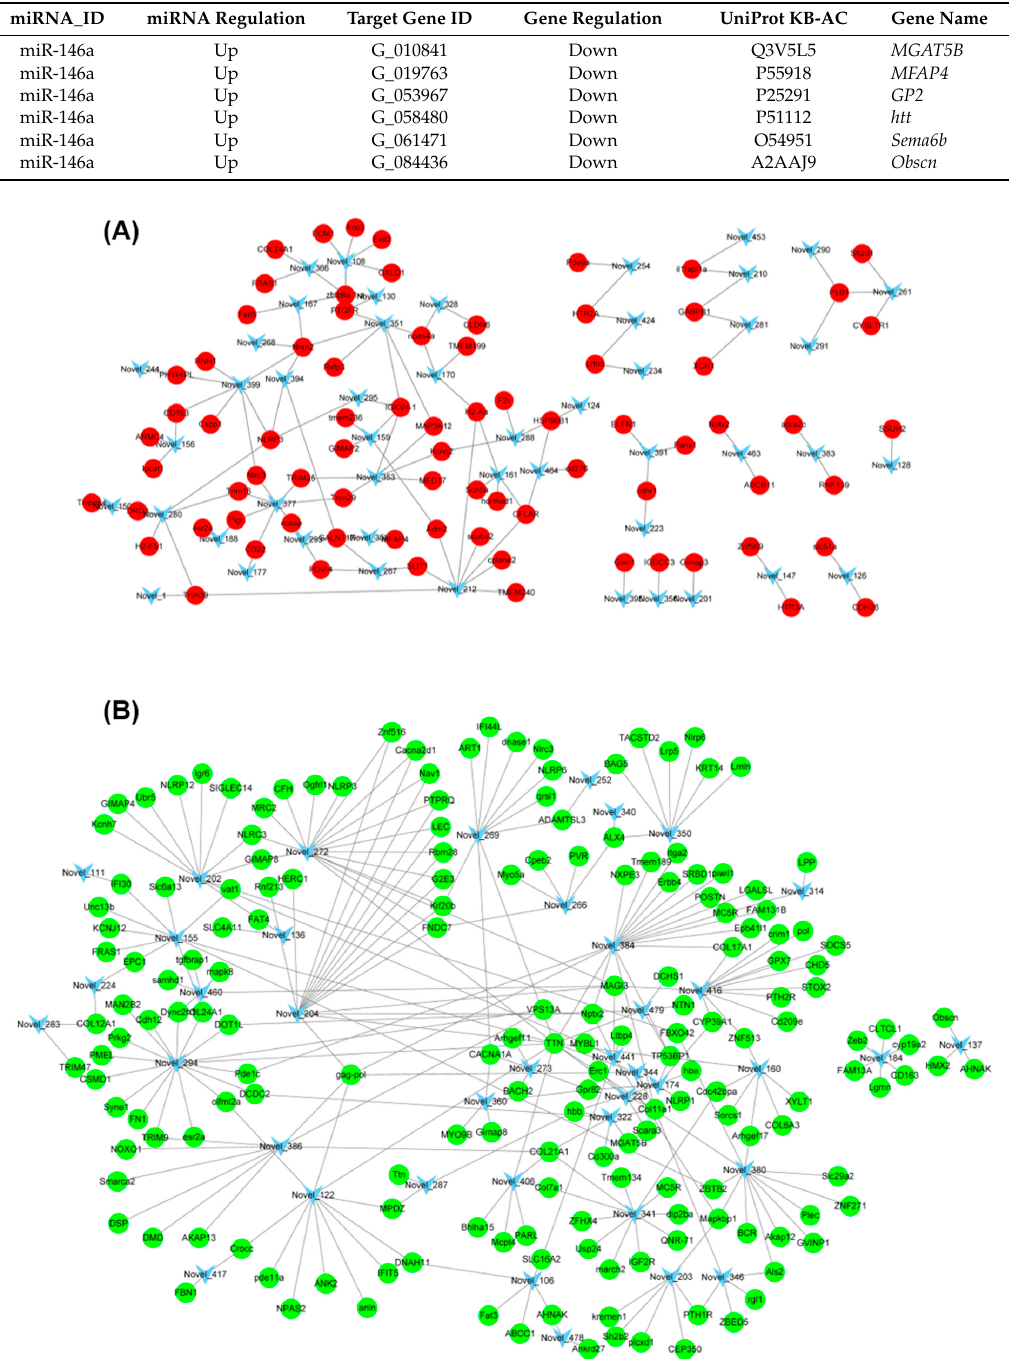
Figure 7. Interaction analysis of novel DE miRNAs and their target DE genes. ( A ) Interaction analysis of down-regulated novel DE miRNAs and their up-regulated target genes (TM vs. WT); ( B ) Interaction analysis of up-regulated novel DE miRNAs and their down-regulated target genes (TM vs. WT).